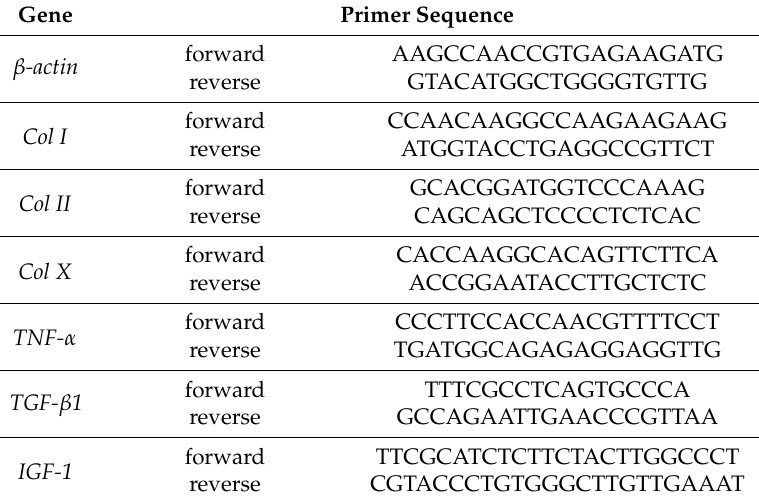
Table 1. Primer sequences for quantitative real-time polymerase chain reaction (qRT-PCR) analysis of gene